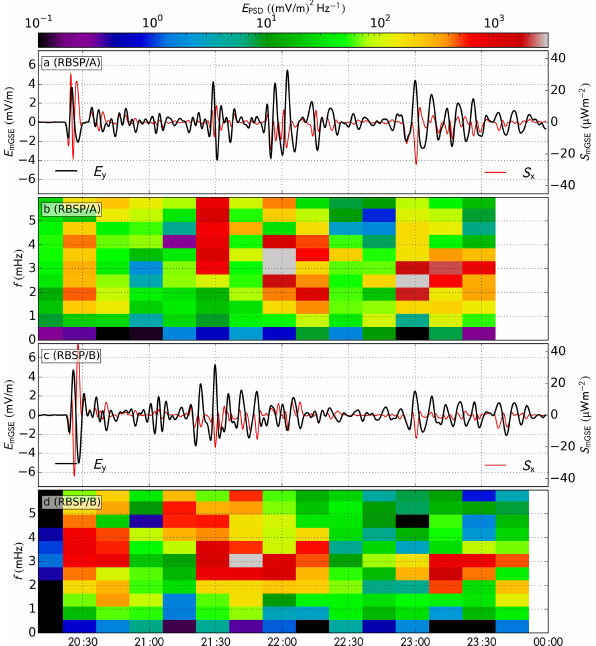
Figure 5. 8 October 2013 event: Poynting flux S xGSM (red line) and electric field E yGSM (black line) measurement by the EFW in- strument onboard the Van Allen Probe A and B (panels a and c respectively) and corresponding power spectral density computed on E y in panels (b) and (d) , respectively. Note that data are band- pass-filtered between 1 and